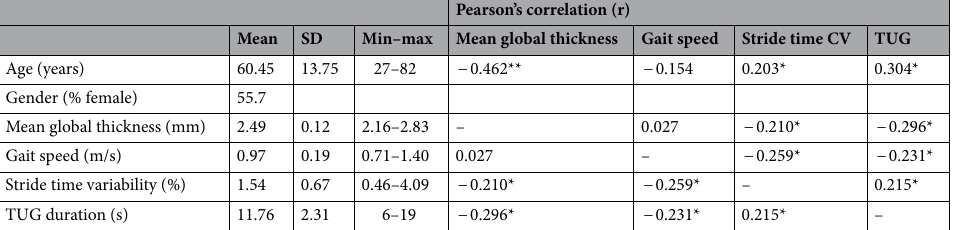
Table 2. Participant characteristics and univariate correlations. * p < 0.05, ** p < 0.001.